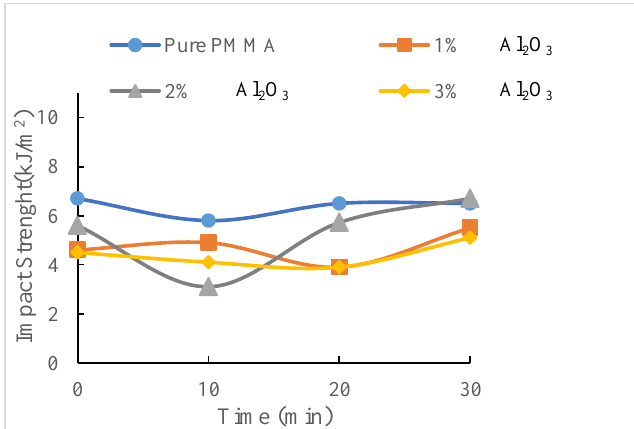
Fig.7: Influence of immersion nanocomposite PMMA + (1%, 2%, 3% of Al Lemon for (10, 20, 30 min), respectively.